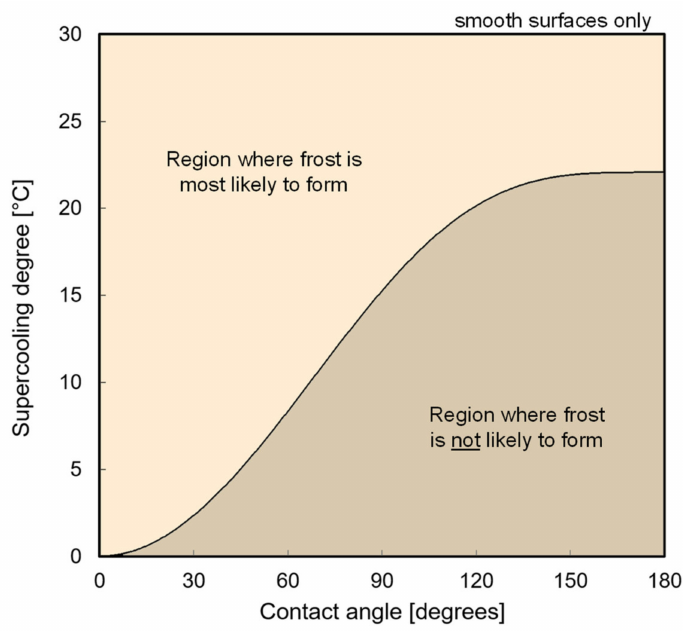
Figure 6. Minimum supercooling degree for the onset of nucleation on a smooth surface as a function of the contact